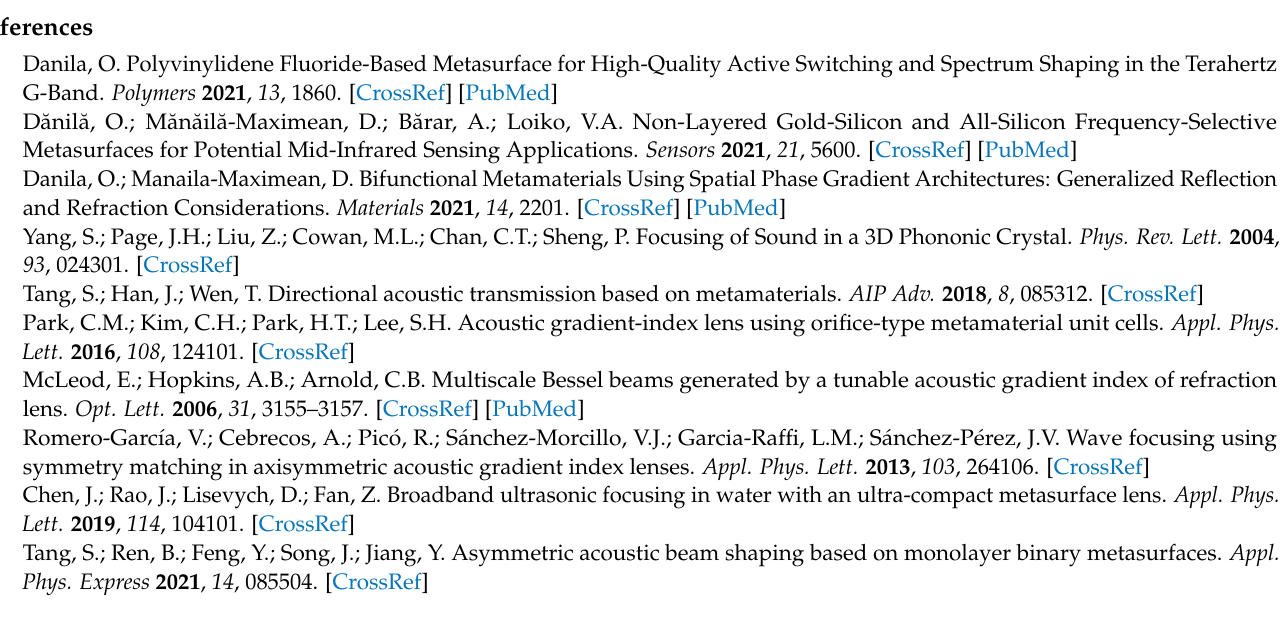
Figure A2. Schematic diagram of acoustic focusing by coding